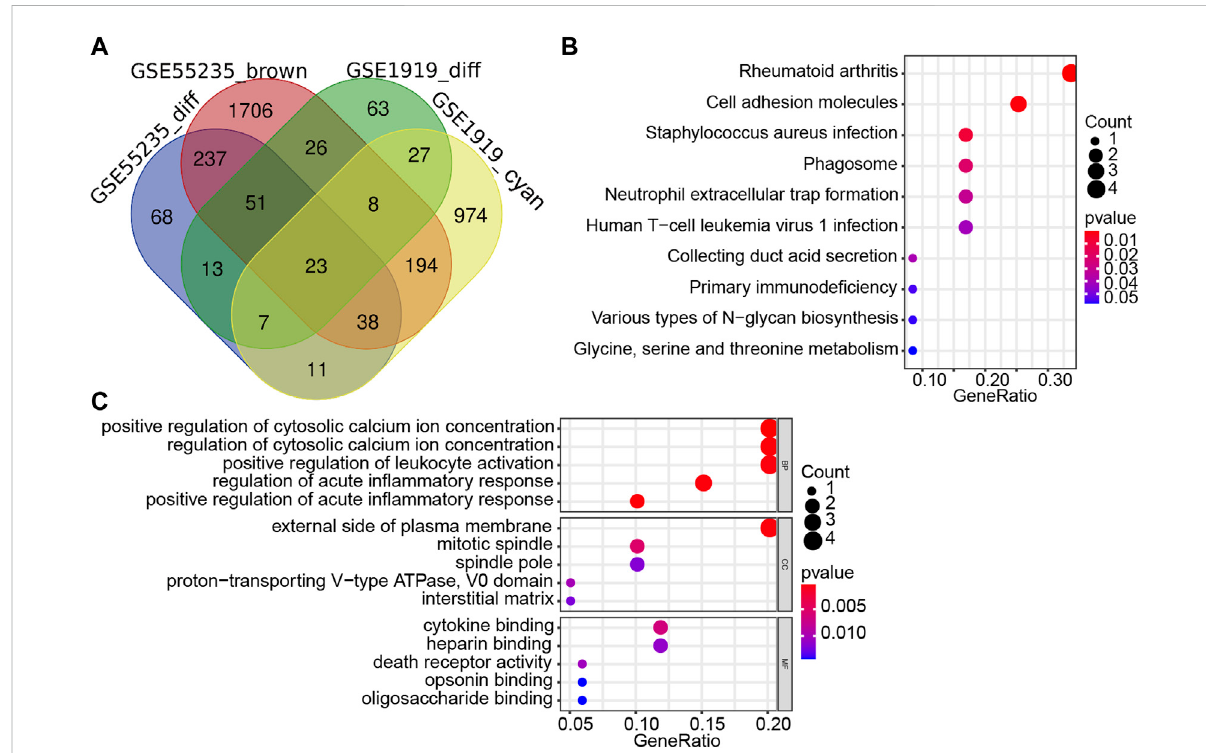
FIGURE 3 Screening and validation of candidate hub genes. (A) Venn diagram revealed 23 overlapping candidate hub genes. (B) Kyoto Encyclopedia of Genes and Genomes (KEGG) pathway analysis of candidate hub genes. (C) Gene ontology (GO) enrichment analysis of candidate hub genes.